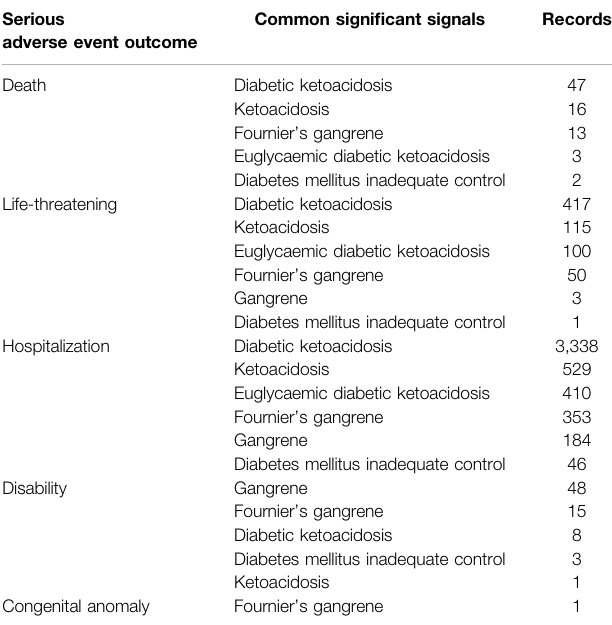
TABLE 4 | Common signi fi cant signals for serious outcomes in